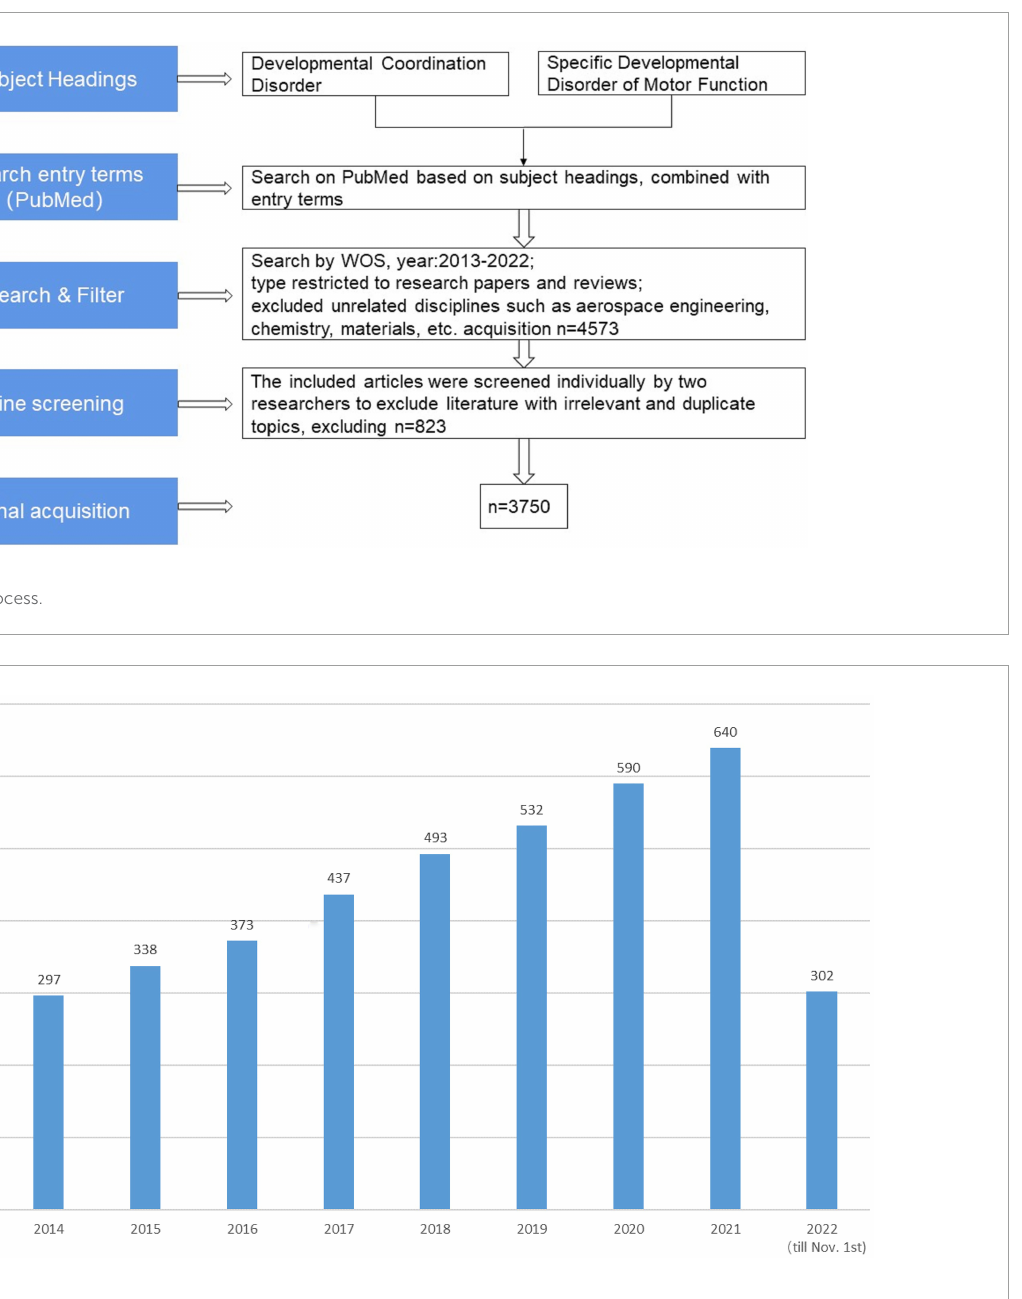
FIGURE2 Annual number of articles related to children’s developmental coordination disorder